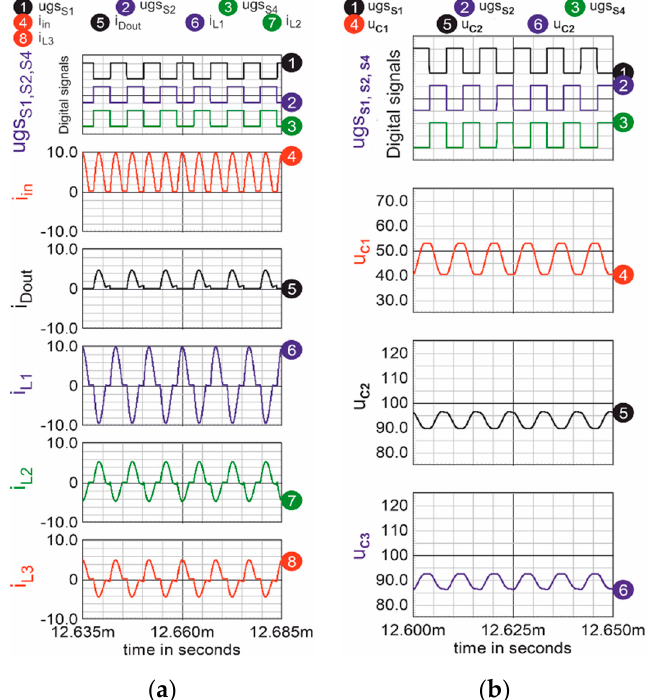
Figure 7. Steady-state operation of the LCSCVMb converter under switching strategy C5: ( a ) Waveforms of the input current, inductors currents, and the current of the output diode (in amperes). ( b ) Voltages (in volts) on capacitors C 1 , C 2 , and C 3 . The results were obtained with the use of ICAP/4 simulation software.